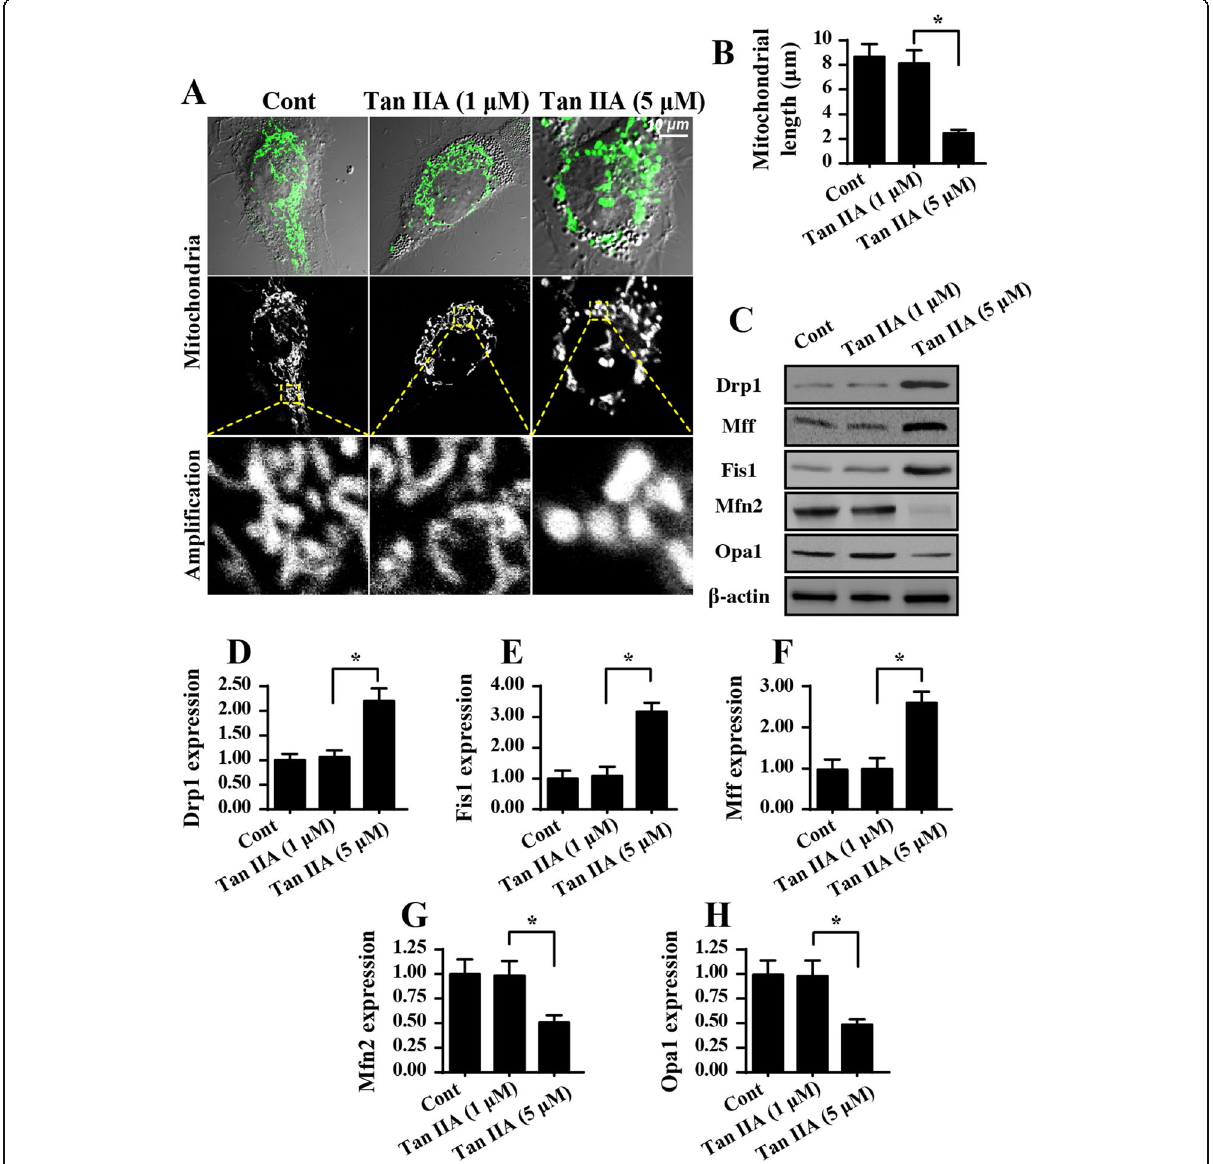
Fig. 4 Tan IIA activates mitochondrial fission in SW837 cells. a-b Immunofluorescence assay for mitochondria using the mitochondrial specific antibody Tom-20. The mitochondrial fragment was counted to quantify the mitochondrial fission. c-h Western blotting for fission-related proteins. Pro-fission factors such as Drp1, Fis1 and Mff were increased in response to Tan IIA treatment. In contrast, anti-fission factors including Mfn2 and Opa1 were also downregulated in Tan IIA-treated cells. * p <